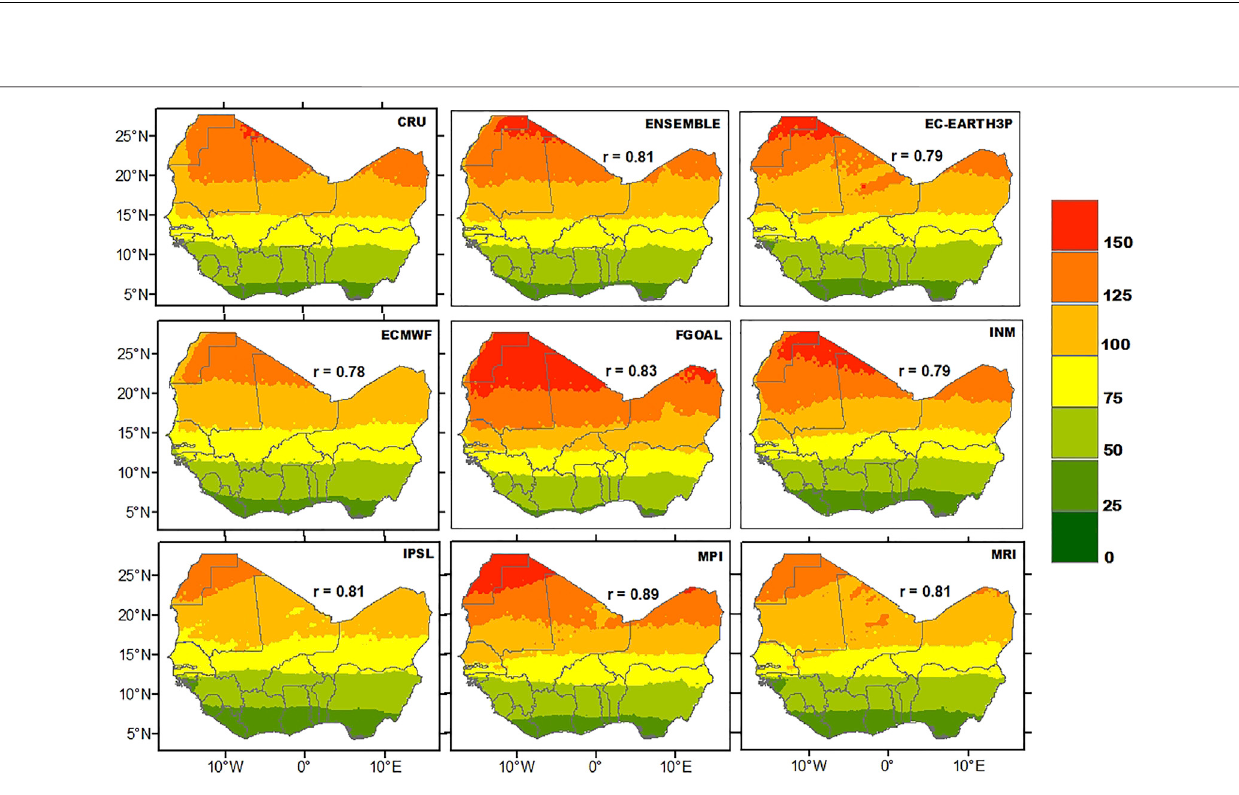
Frontiers in Earth Science |